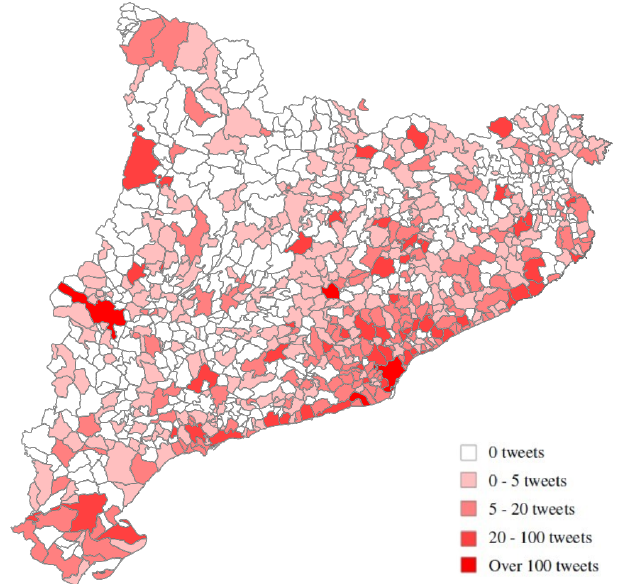
Figure 2. Spatial distribution of the